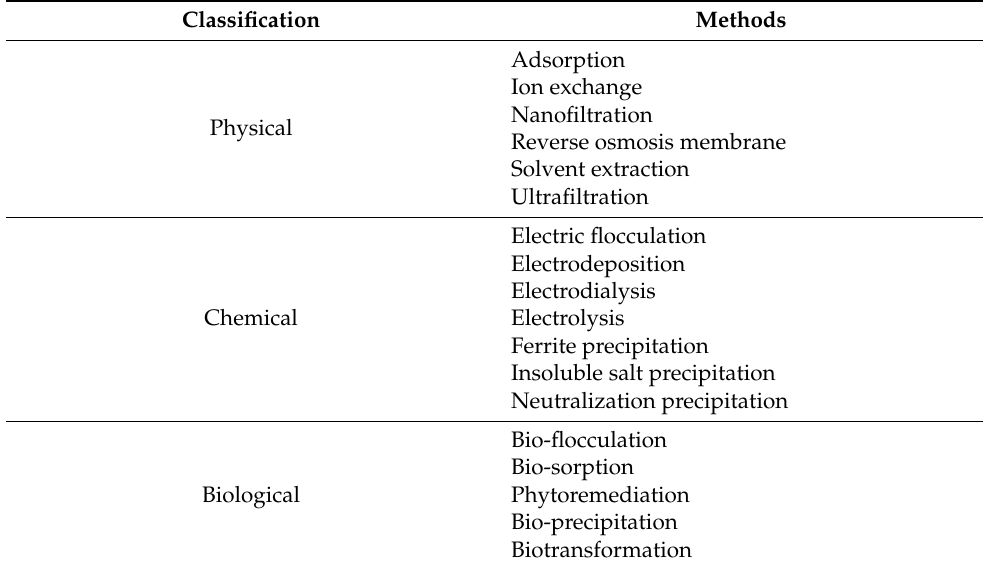
Table 3. Common method for heavy metals removal in water. Adopted from reference [15] (copyright reserved Elsevier,